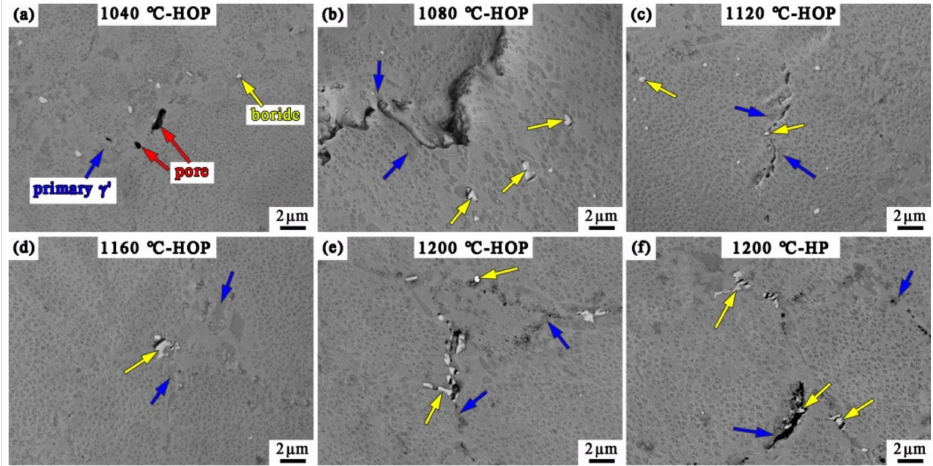
Figure 11. BSE images near the fracture surface of the HOPed and HPed samples: ( a ) 1040 ◦ C-HOP; ( b ) 1080 ◦ C-HOP; ( c ) 1120 ◦ C-HOP; ( d ) 1160 ◦ C-HOP; ( e ) 1200 ◦ C-HOP; ( f ) 1200 ◦ C-HP.